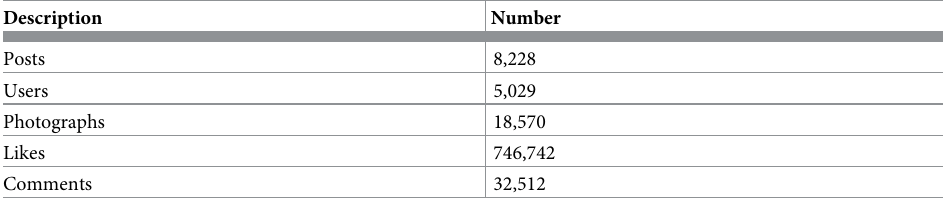
Table 2. Overview of the Depot Boijmans dataset (January 2020—December